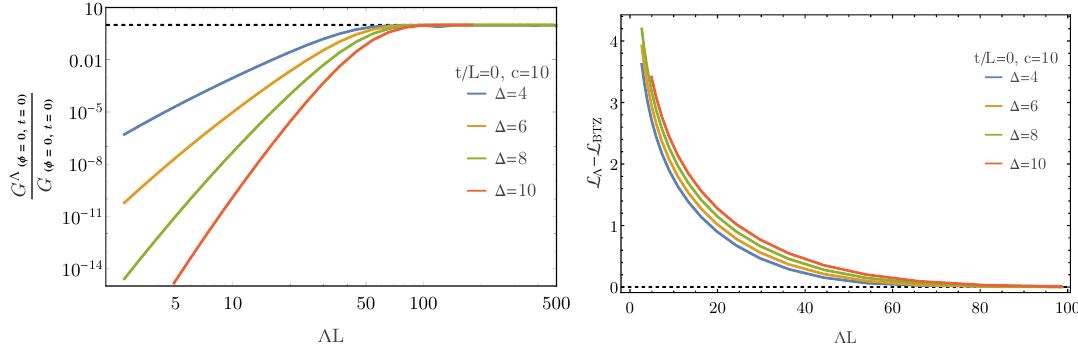
Figure 5 . Normalized Wightman function with (cid:12)nite cuto(cid:11) (left) and length di(cid:11)erence from BTZ (right) as de(cid:12)ned in eq. (4.7) for (cid:12)xed (cid:12)=L = 1 = 2. The central charge is c = 10 and space separation is zero.